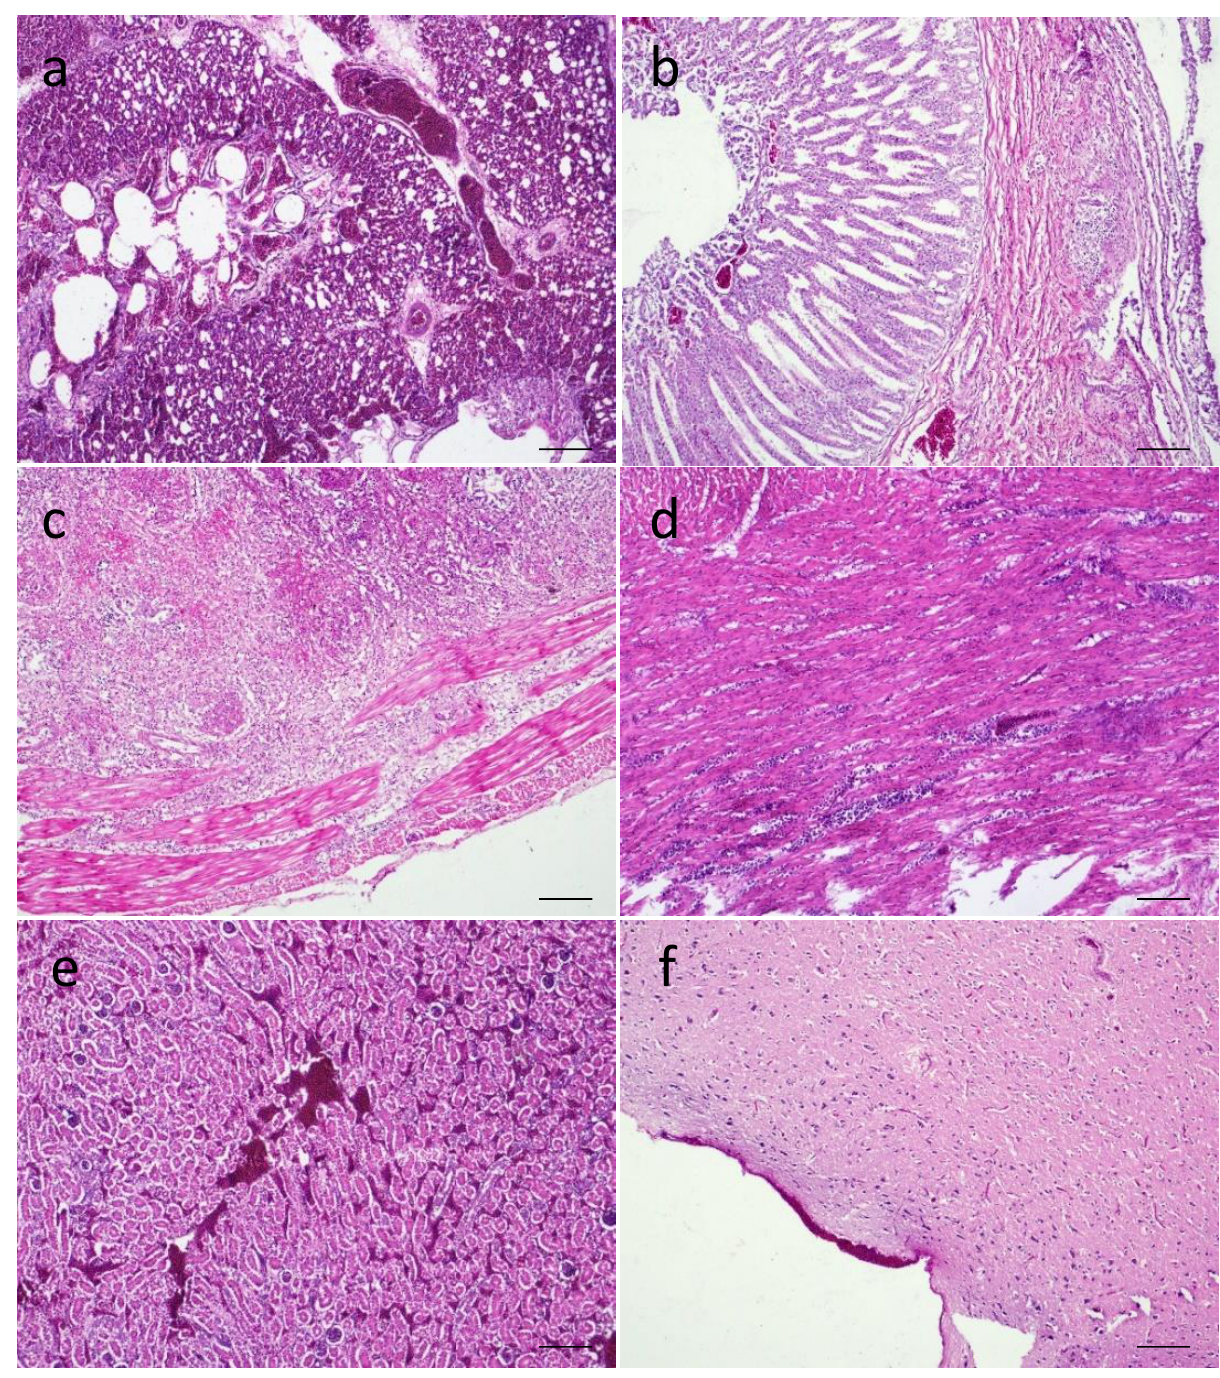
Figure 5. Microscopic changes in the tissues of LT67-inoculated chickens. ( a ) Section of lungs showing congestion and collapsed alveoli, ( b ) section of proventriculus showing focal proventriculitis with congestion and sloughing of epithelial cells, ( c ) section of intestine showing transmural enteritis, ( d ) section of heart showing focal myocarditis, € ( e ) section of kidney showing severe congestion and necrosis, and ( f ) section of brain showing congestion in the meninges. H&E stain. Bar (=50 μm) indicates magnification.